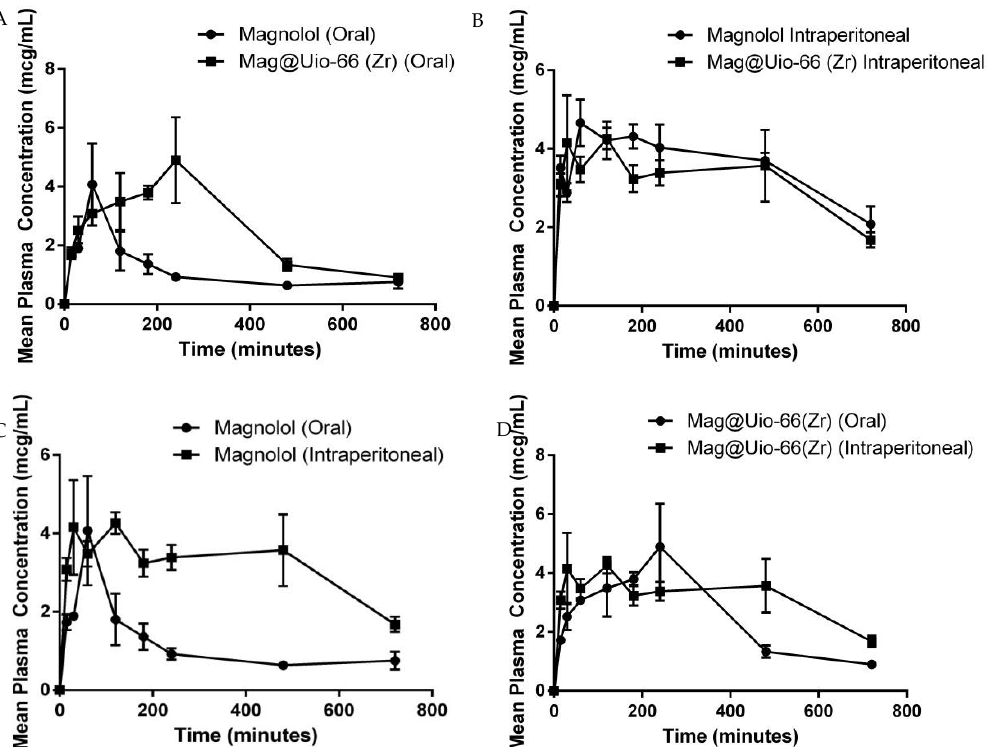
Figure 8. Area under the curve (AUC 0–720 ) graph of ( A ) magnolol (oral) and mag@Uio-66(Zr) (oral), ( B ) magnolol (intraperitoneal) and mag@Uio-66(Zr) (intraperitoneal), ( C ) magnolol (oral) and magnolol (intraperitoneal), and ( D ) mag@Uio-66(Zr) (oral) and mag@Uio-66(Zr) (intraperitoneal). n = 3. Data plotted as mean ± S.E.M. in time (minutes) and mean plasma concentration of magnolol (µg/mL).